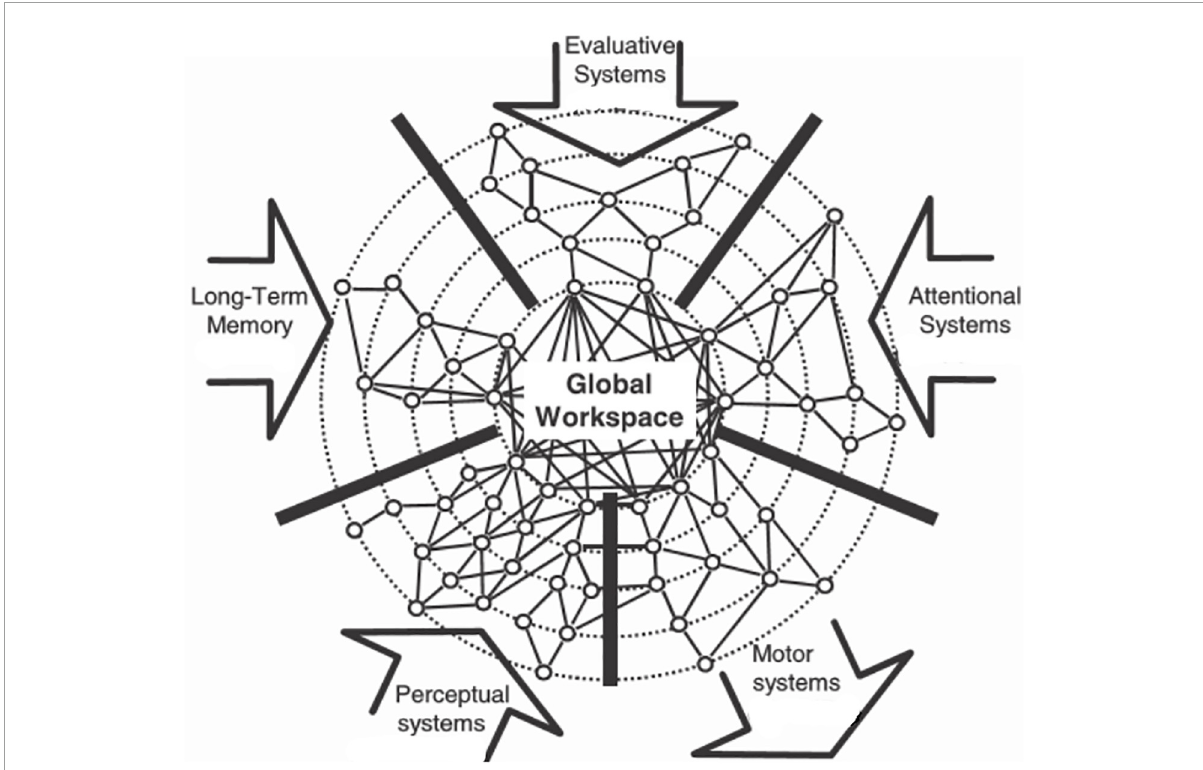
FIGURE7 Global Neuronal Workspace (GNW) hypothesis for the generation of consciousness in the brain. The input arrows to the global workspace show systems (perceptual, long-term memory, evaluative, attentional) which can contribute to an interactive processing with the result of the generation of awareness of the content of stimuli and consciousness about the preparation and execution of behavior (motor systems output arrow). [Modified from Dehaene and Changeux (2011); their Figure 6, upper right